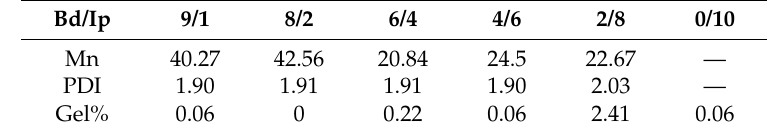
Table 2. Effect of Bd/Ip mole ratios from 9:1 to 0:10 on the gel content of the resulting copolymer.